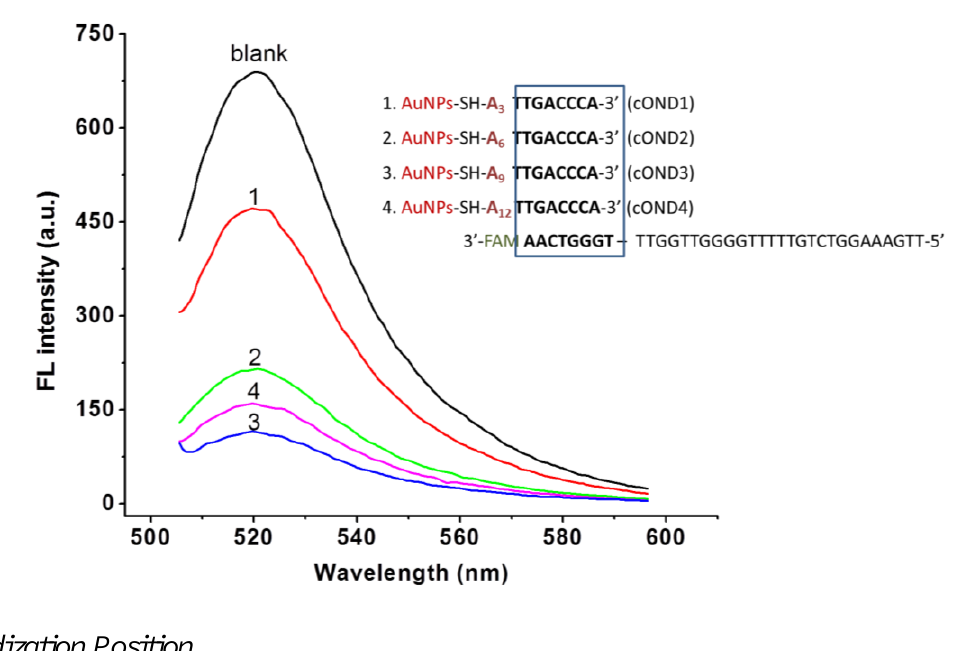
Figure 2. Effects of spacer length on FRET efficiency after FAM-Apt hybridizing with cODN-AuNPs. The concentration of FAM-Apt is 120 nM, and blank represents only FAM-Apt existed. Curves 1, 2, 3 and 4 represent the fluorescence of four kinds of Apt-AuNPs containing 3, 6, 9 or 12 nt spacers,